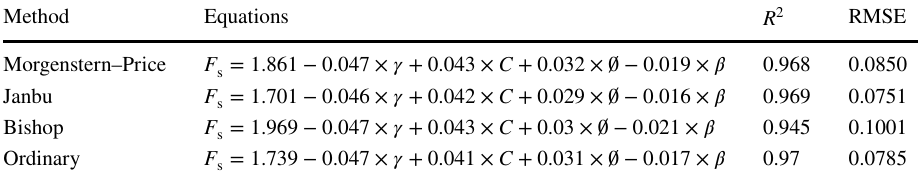
to obtain the factor of safety of slopes